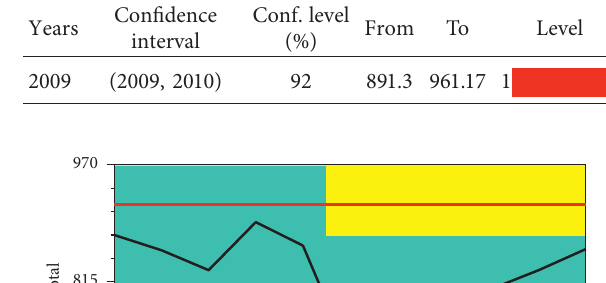
Figure 11: Free State: CUSUM plot. Table 8: Table of significant changes for murder in Free State.